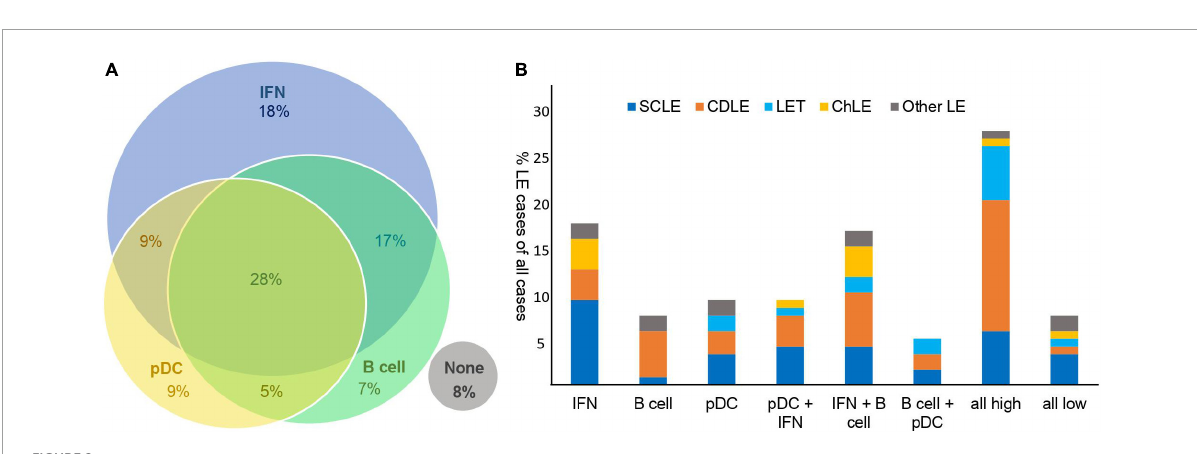
FIGURE2 Classification of lupus erythematosus (LE) skin samples with regard to significant expression of B cell-, pDC-, and interferon-markers into eight inflammatory expression groups (A) and the distribution of LE subtypes within those expression groups (B) . (A) Division of the n = 119 LE skin samples according to their major type of immunological infiltrate assessed via staining for CD20 (B cells), CD123 (pDCs) and MXA (as IFN surrogate) into eight expression groups: IFN, B cell, pDC, pDC + IFN, IFN + B cell, B cell + pDC, all high, all low. Expression scores > 1 were considered significantly and characteristically infiltrated, and LE cases were grouped accordingly. (B) Distribution of different LE subtypes (SCLE, CDLE, LET, ChLE and other LE) within the expression groups. The ratio of LE subtypes is shown proportionally as % cases of all cases ( n =